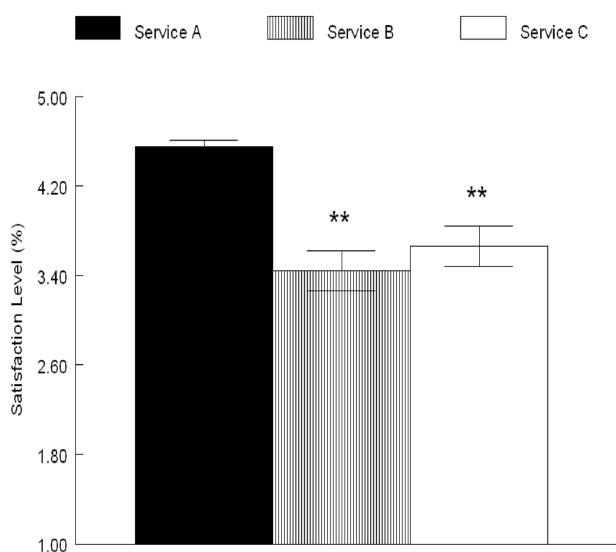
FIGURE 1 - Average satisfaction level of the users of pharmaceutical services A (private with PC), B (private without PC), C (public without PC). The numbers represent the mean ± S.E.M. **p<0.01 in relation to service